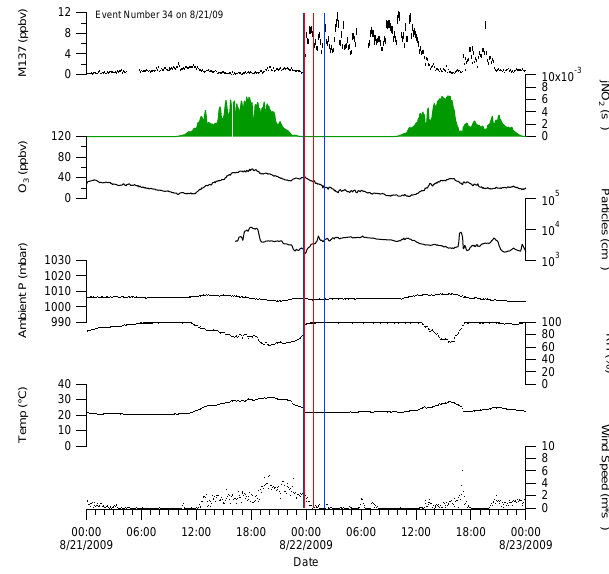
Fig. 3. An example of a Type A event, from 22 August 2009 (UTC), showing a large increase in monoterpenes (M137) at the same time as a rain storm arrives at Thompson farm. Ozone (O 3 ), particles, at- mospheric pressure (Ambient P), relative humidity (RH), tempera- ture (Temp), and wind speed during the storm event are also shown. Blue lines indicate the period of precipitation as determined by the radar, while red lines indicate peak precipitation as described in the text. The arrival precipitation is validated by simultaneous changes in meteorological